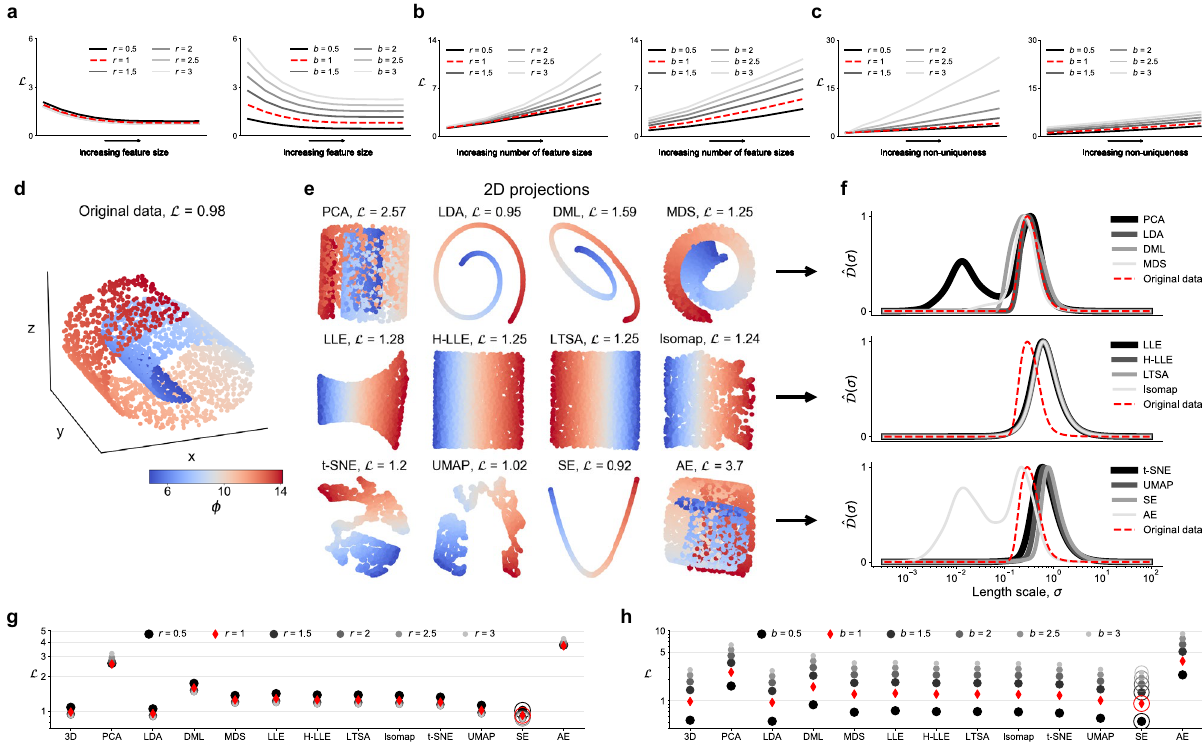
Figure 9. Illustrative demonstration of the effect of changing the cost function’s hyper-parameters, r and b . ( a – c ) Costs corresponding to toy functions from Fig. 3 when setting r and b to non-unity values. ( d ) The original 3D swiss roll dataset with the cost reported for the original 3D parameterization using r = 1 and b = 1 . ( e ) 2D swiss roll dataset projections with the resulting costs using r = 1 and b = 1 . ( f ) Comparison of the ˆ D (σ) curves between generated 2D swiss roll dataset projections. The ˆ D (σ) curve for the original 3D parameters is shown with the red dashed line for reference. ( g ) Costs for the 3D swiss roll data parameters and its various 2D projections with b set fixed to unity, and with changing r . ( h ) Costs for the 3D swiss roll data parameters and its various 2D projections with r set fixed to unity, and with changing b . With the circular outlines in ( g , h ), we mark the lowest costs for any of the 2D projections which consistently happens for the SE manifold, irrespective of the values selected for r and b